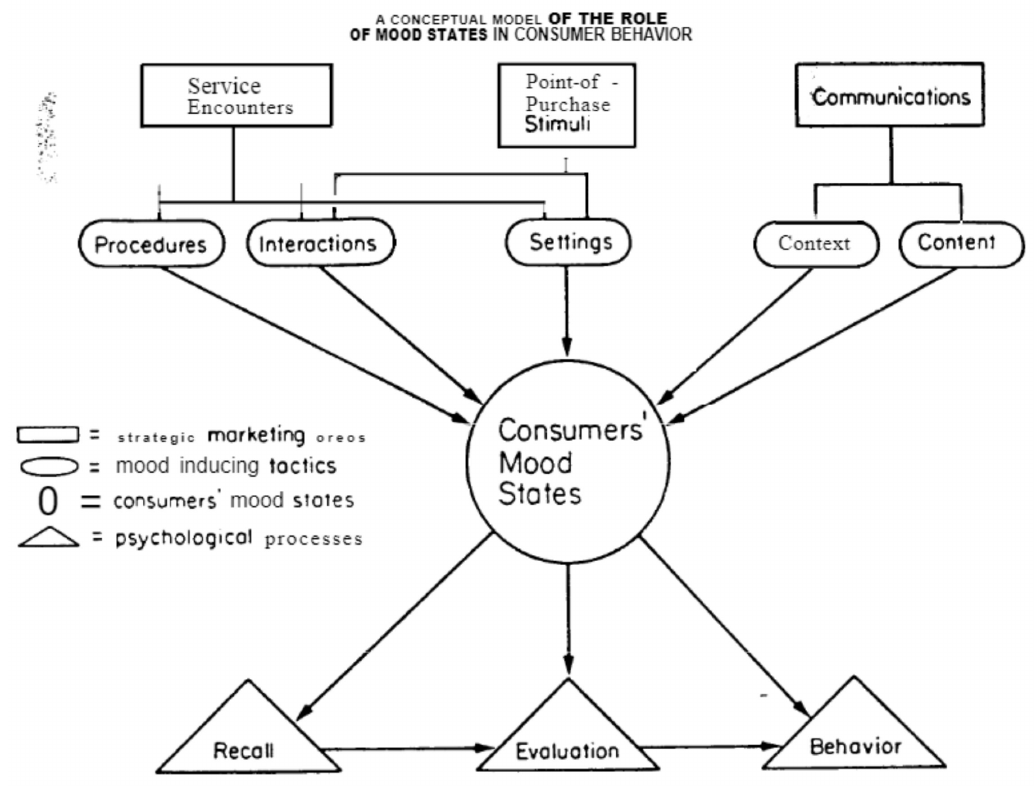
Figure 2. Content and Induction of Consumer Mood States